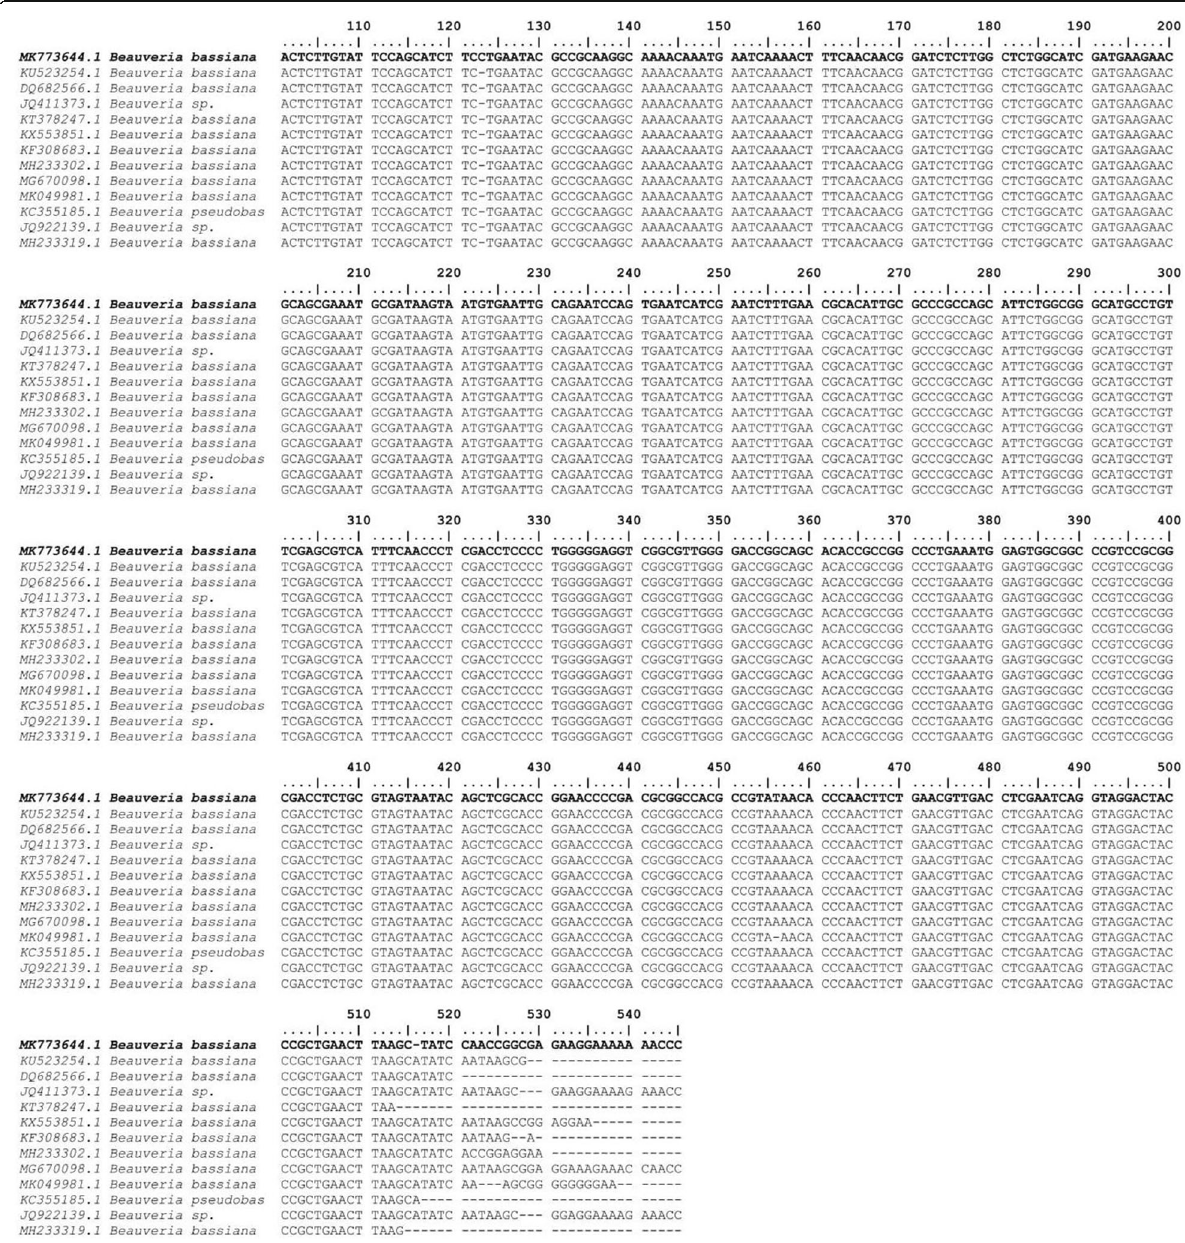
Fig. 1 Sequence alignment of ITS1 gene region of the present Beauveria bassiana with the most closely related species. Only variable sites are shown. (.) represents bases identical to those of the first sequence and (-) indicates